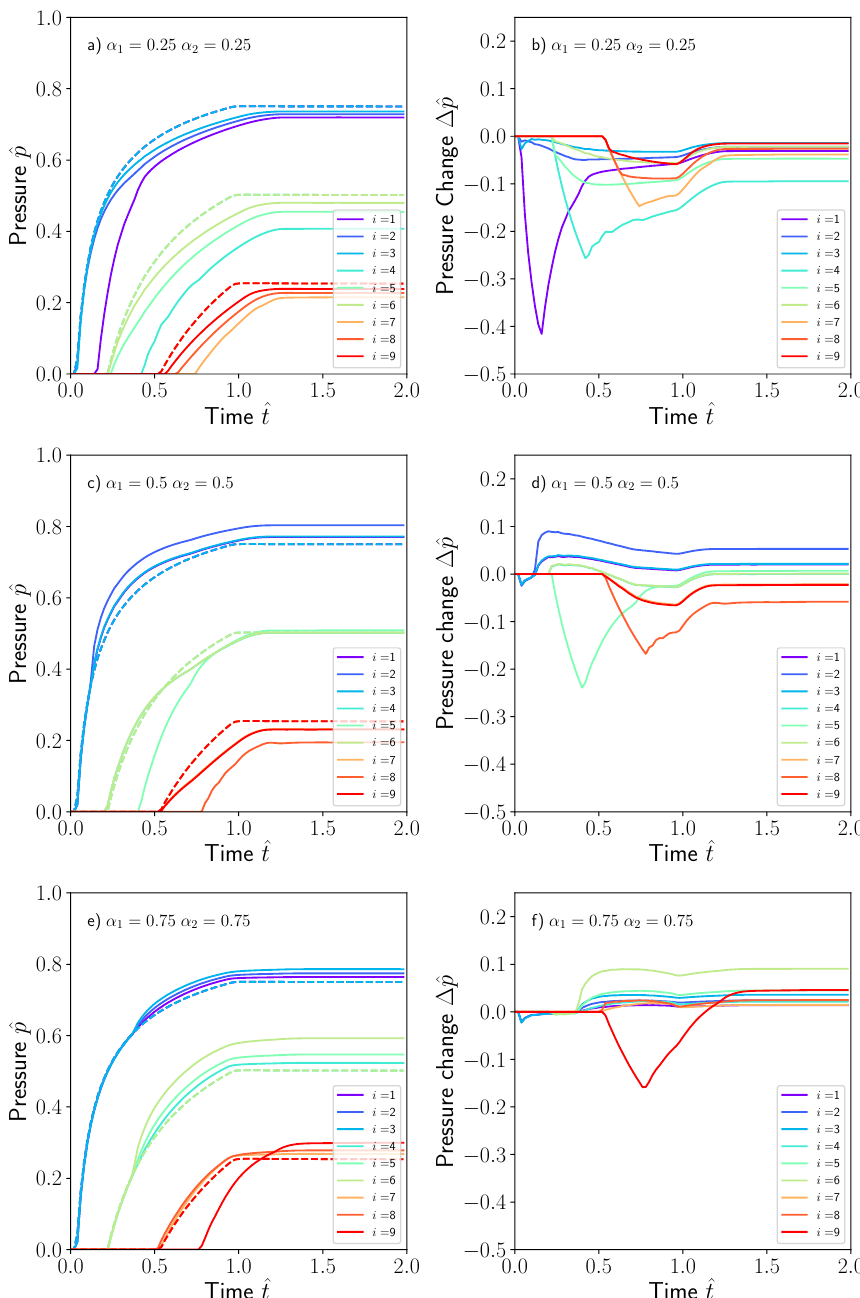
Figure 4. Non-dimensional pressure evolution ˆ p ( ˆ t ) for the nine sensors distributed in the mould containing a 0.25 L square dissimilar material region at ( a ) α 1 = 0.25, α 2 = 0.25, ( c ) α 1 = 0.5, α 2 = 0.5 and ( e ) α 1 = 0.75, α 2 = 0.75. Dashed lines corresponds with the pressure sensor evolution in the absence of dissimilar material region. The pressure changes ∆ ˆ p ( ˆ t ) in ( b , d , f ) are as the difference, or perturbation, between the local pressure value with and without dissimilar material region. For visualization purposes, the non-dimensional time was arbitrarily extended to ˆ t =